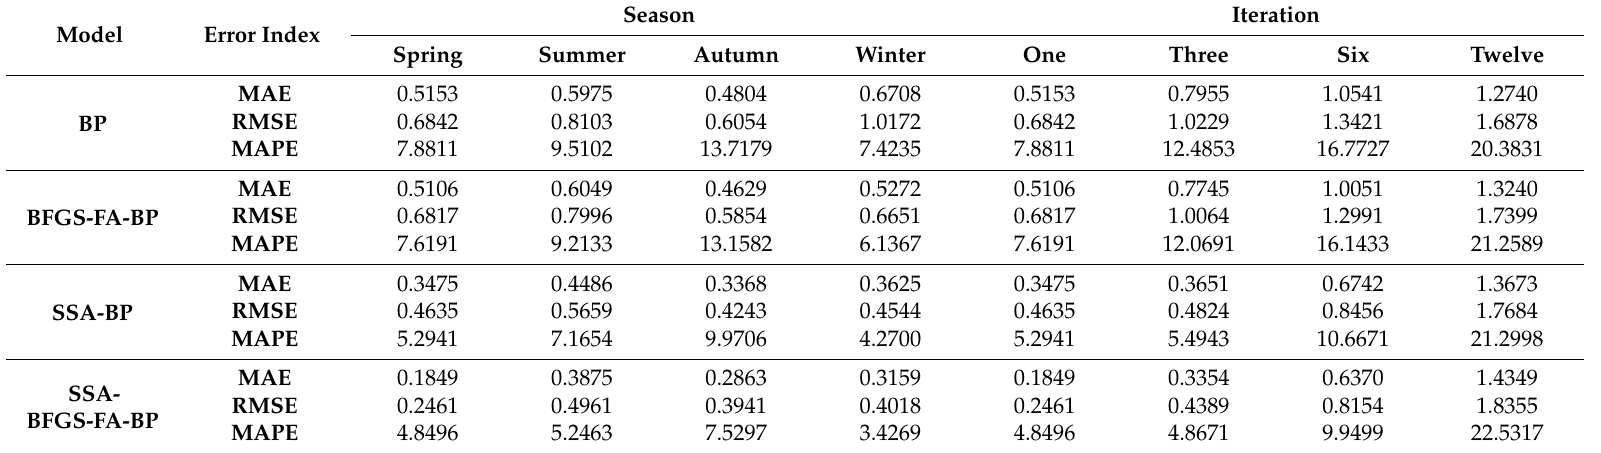
Table 10. MAE, RMSE, and MAPE of four seasons and various iterations in one site for each forecasting model.